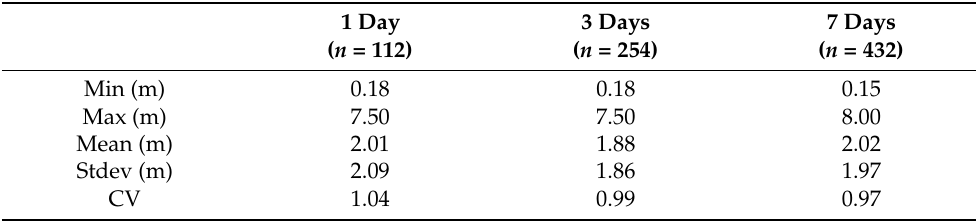
Table 2. Secchi depth statistics of 1-day, 3-day, and 7-day time window matching data. Coefficient of variation (CV) =